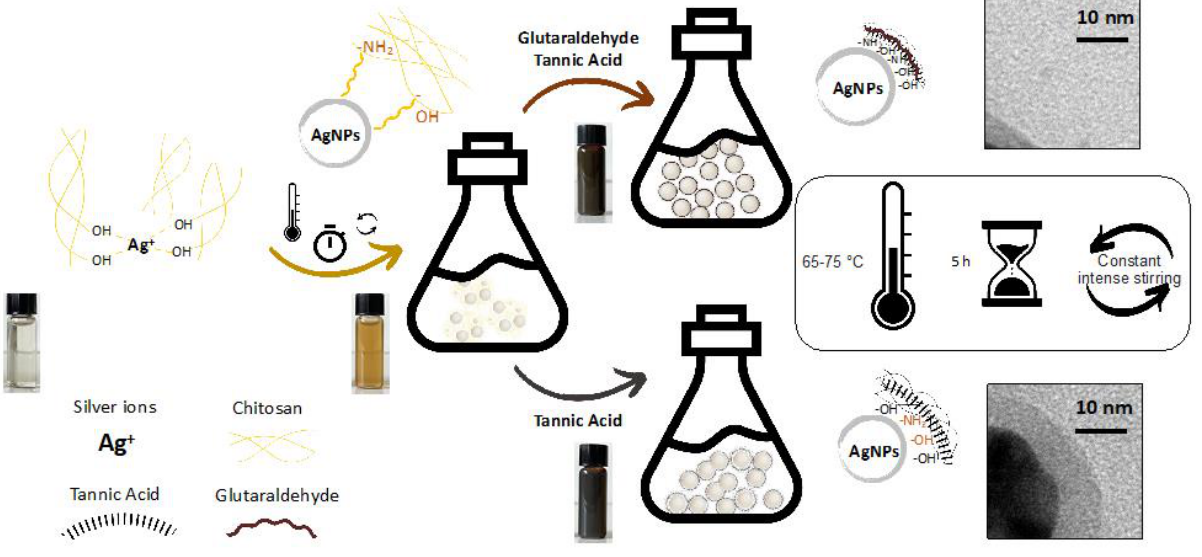
Scheme 1. Synthetic scheme of the synthesis of nanocomposites. Table 1. Labels for the samples, using different reducing and stabilizing agents. Composition of the Nanocomposite: Stabilizing and Reducing Agent(s) and Presence of AgNPs